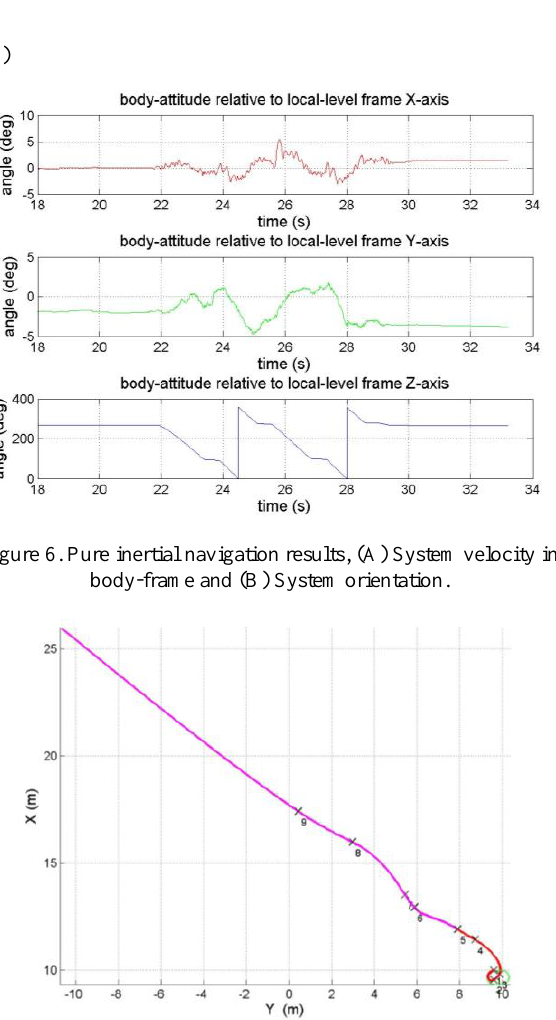
Figure 7. Pure inertial navigation position